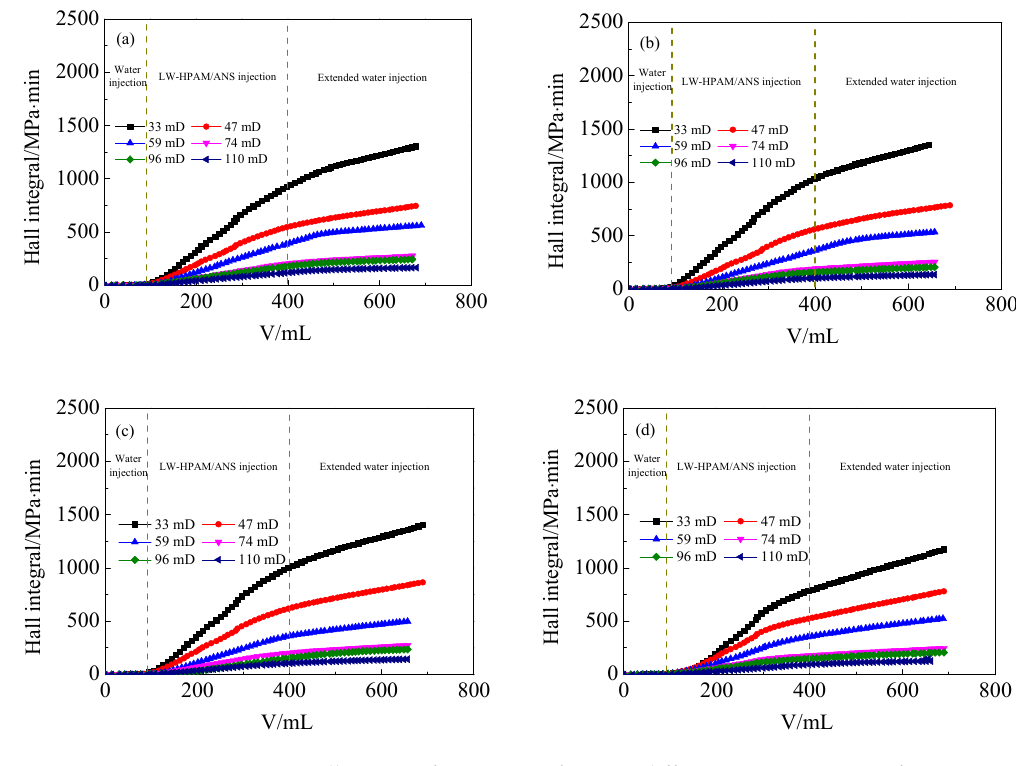
Figure 17. The Hall derivative of HPAM/ANS decreased with increasing core permeabil- ity.